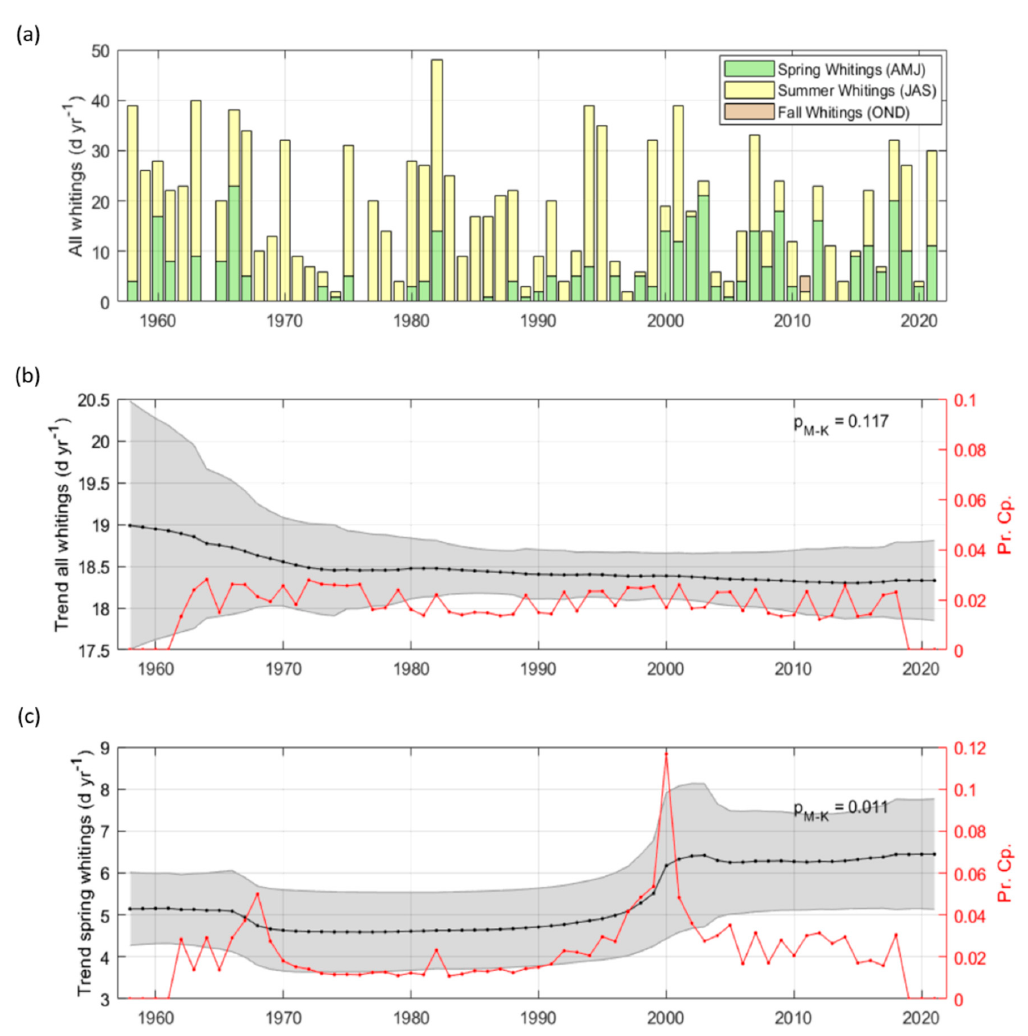
Figure 7. ( a ) Reconstruction of past ‘unseen’ whiting days from 1958 to 2021 (Class 1 only, >15 km 2 , expressed as days of whiting per year) based on the RF algorithm. Whitings are separated following the season of occurrence (green: spring, yellow: summer, brown: fall). ( b ) BEAST decomposition of the time series of all whitings, with the trend indicated in black and the standard deviation in grey. The probability of finding a changing point in the trend is shown in red. ( c ) same as ( b ) but for spring whiting days only. The p -values of the Mann–Kendall tests are specified on ( b , c ).